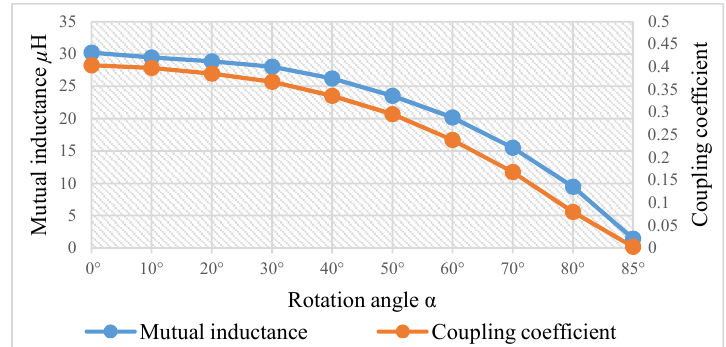
Figure 2. Winding methods of transceiver (Tx) and receiver (Rx) coils. Blue coils represent limits of design scenario (or part of it). ( a ) Hemicylindrical windings of Tx and Rx coils: DL (64, 50). ( b ) Opposite hemicylindrical windings of Tx and Rx coils (Case 1). ( c ) Opposite hemicylindrical windings (Case 2). ( d – f ) Other models with fewer number of turns (conducted with Ansys Maxwell 3D, USA).